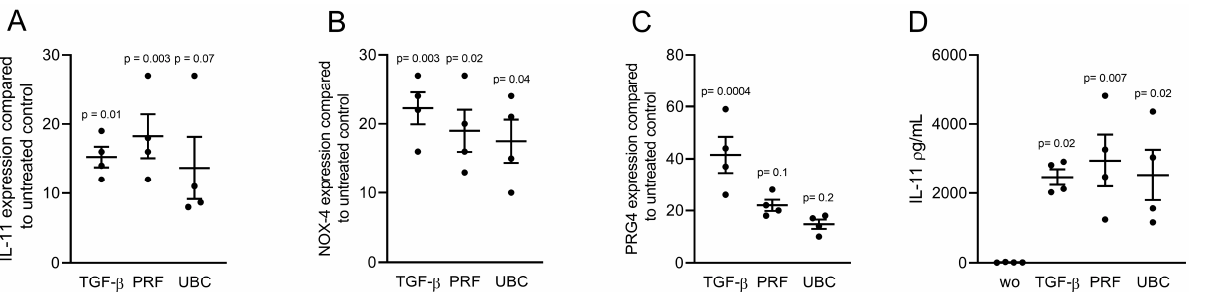
Figure 2. Lysates from PRF and UBC increase TGF- β target genes in gingival fibroblasts. Gingival fibroblasts were incubated with PRF and UBC lysates, and TGF- β was used as a positive control. ( A – C ) Real Time-PCR analysis of IL-11, NOX-4 and PRG4. ( D ) Quantification of IL-11 levels in the supernatant by immunoassay. n = 4. Statistical analysis was based on uncorrected Dunn’s tests, and p values are indicated compared to the untreated control. Significance was set at p < 0.05.